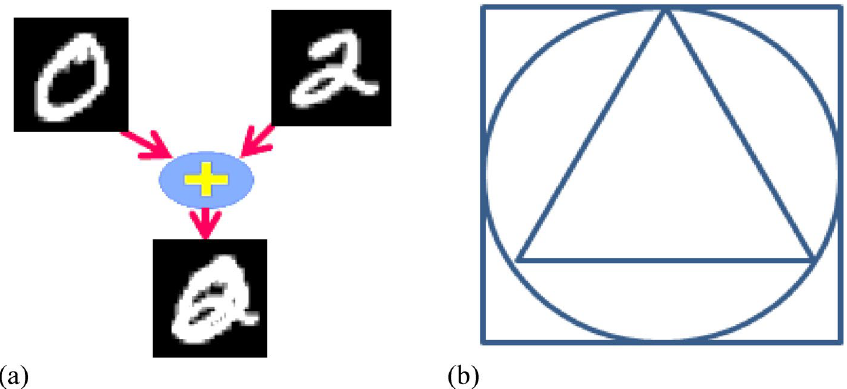
Figure 6. The intertwined pattern consists of square, circle, and triangle.